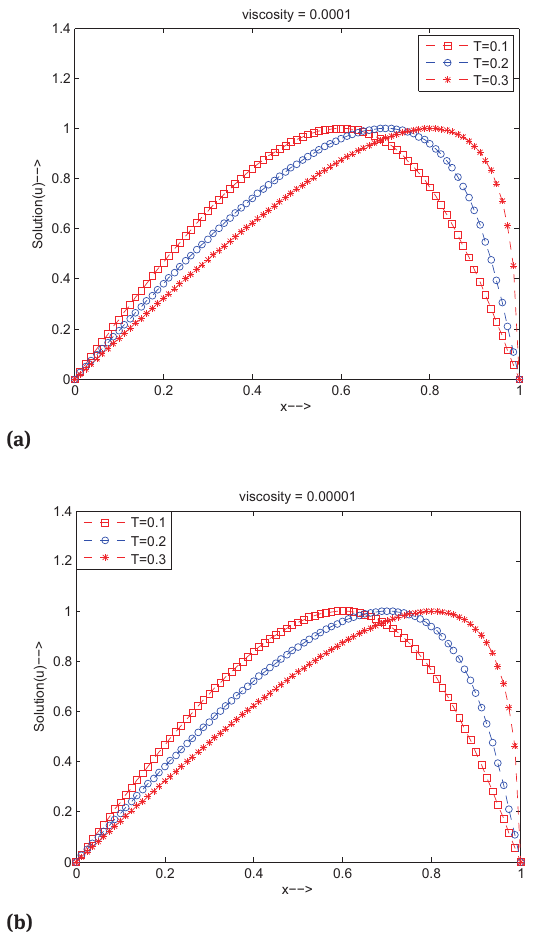
Fig. 3: Example 1: Physical behavior of numerical solutions at differ- ent times with Δx = 0.0125 and Δt = 0.001 . (a) ν = 0.0001 (b) ν = 0.00001 .